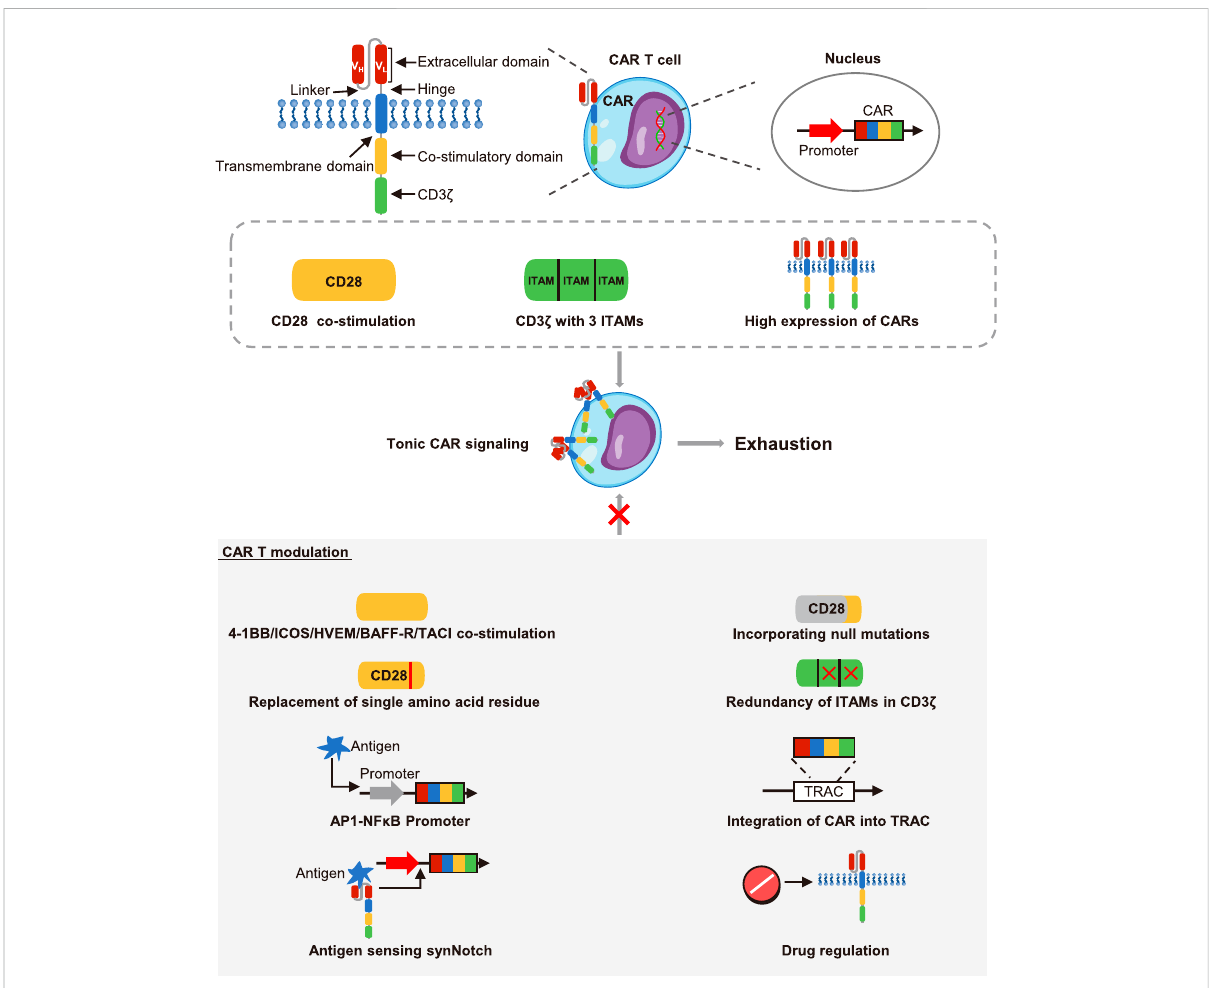
FIGURE 1 TheeffectsofCARsstructureonCARTcellexhaustion.TheCARscontainedanextracellulardomain,ahingeregion,atransmembranedomain, a co-stimulatory domain and a CD3 ζ stimulatory domain. The extracellular domain was composed of the variable heavy chain (V H ) and the variable light chain (V L ) connected by a linker. The upstream promoter initiated the strong expression of CARs on the cell surface. However, the CD3 ζ with 3immunoreceptortyrosine-basedactivationmotifs(ITAMs),CD28co-stimulationandconstitutivelyhighexpressionofCARscouldcausetonic CAR signaling and promote cell exhaustion. However, the 4-1BB, ICOS, HVEM, BAFF-R, and TACI co-stimulation reduced the exhaustion of CAR T cells. Both incorporation of null mutations and replacement of single amino acid residue in CD28 co-stimulation could inhibit exhaustion. Redundancy of ITAMs could also inhibit exhaustion. Besides, the synthetic activator protein 1-nuclear factor κ B (AP1-NF- κ B) promoter, the T cell receptor alpha constant locus (TRAC) that contained CAR structure, the synNotch-CAR circuits, and drug regulation could all restrain the CARs expression. Then the ligand-independent tonic signaling and exhaustion were thus